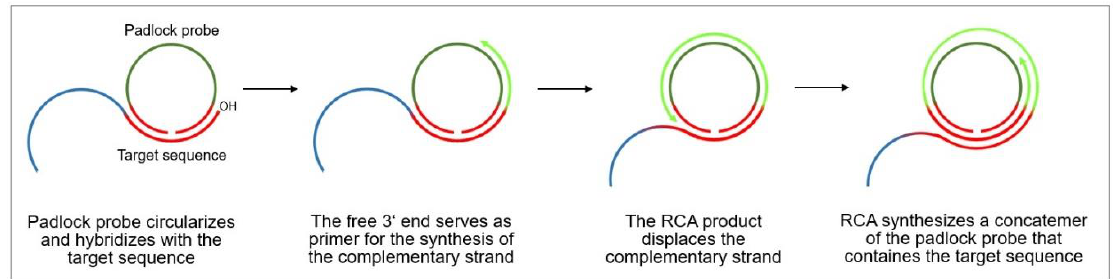
Figure 13. Schematic representation of the mechanism of rolling circle amplification, based on the research of [108].